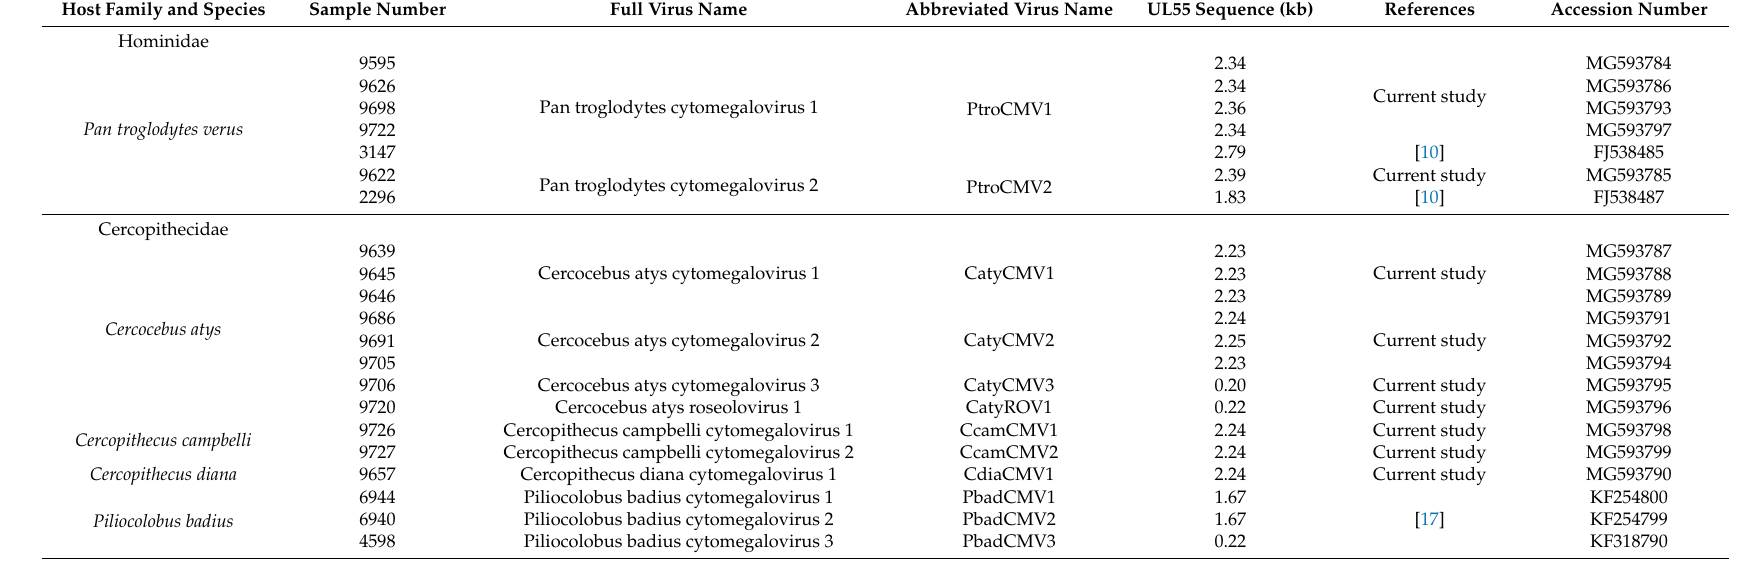
Table 2. Cytomegaloviruses of nonhuman primates in Taï National Park, C ô te